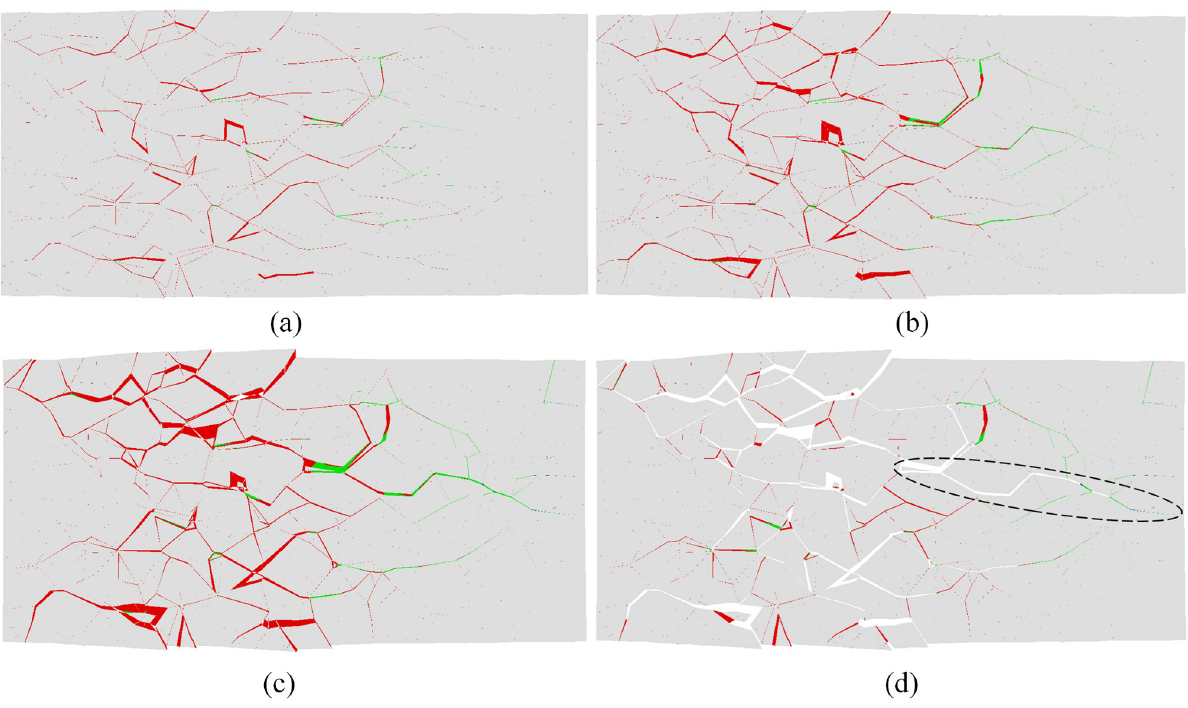
Fig 12. Progressive fracture process of the slice at a velocity of 30.0 m/s (the left face is the impacting face, and the red and green traces depict the cohesive element that has been deleted mainly due to shear failure and tensile failure, respectively): (a) at 0.06 ms; (b) at 0.09 ms; (c) at 0.15 ms; (d) at 0.15 ms, the deleted cohesive elements are not